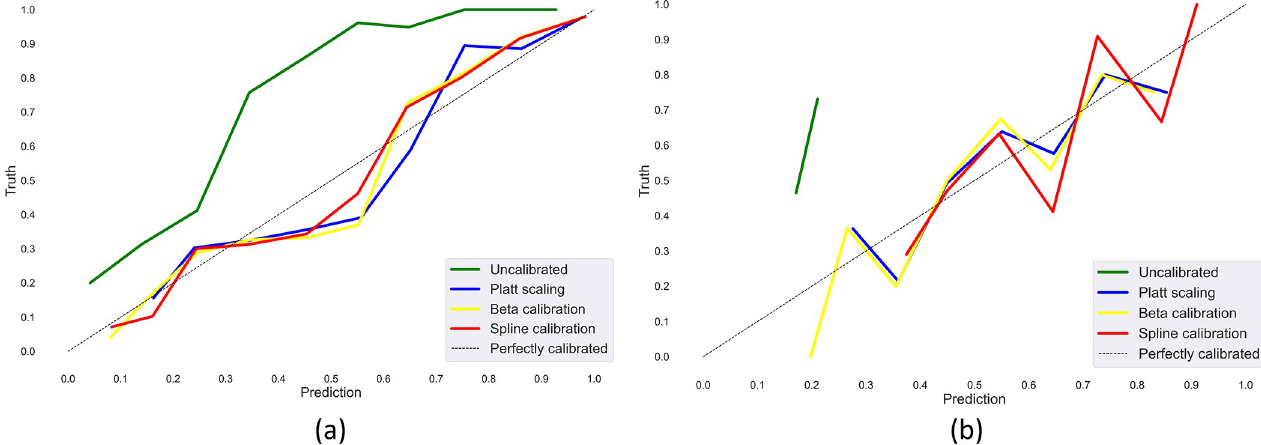
Fig 4. Reliability diagrams obtained using the uncalibrated and calibrated probabilities for the Set-20 dataset constructed from (a) APTOS’19 fundus and (b) Shenzhen TB CXR datasets.